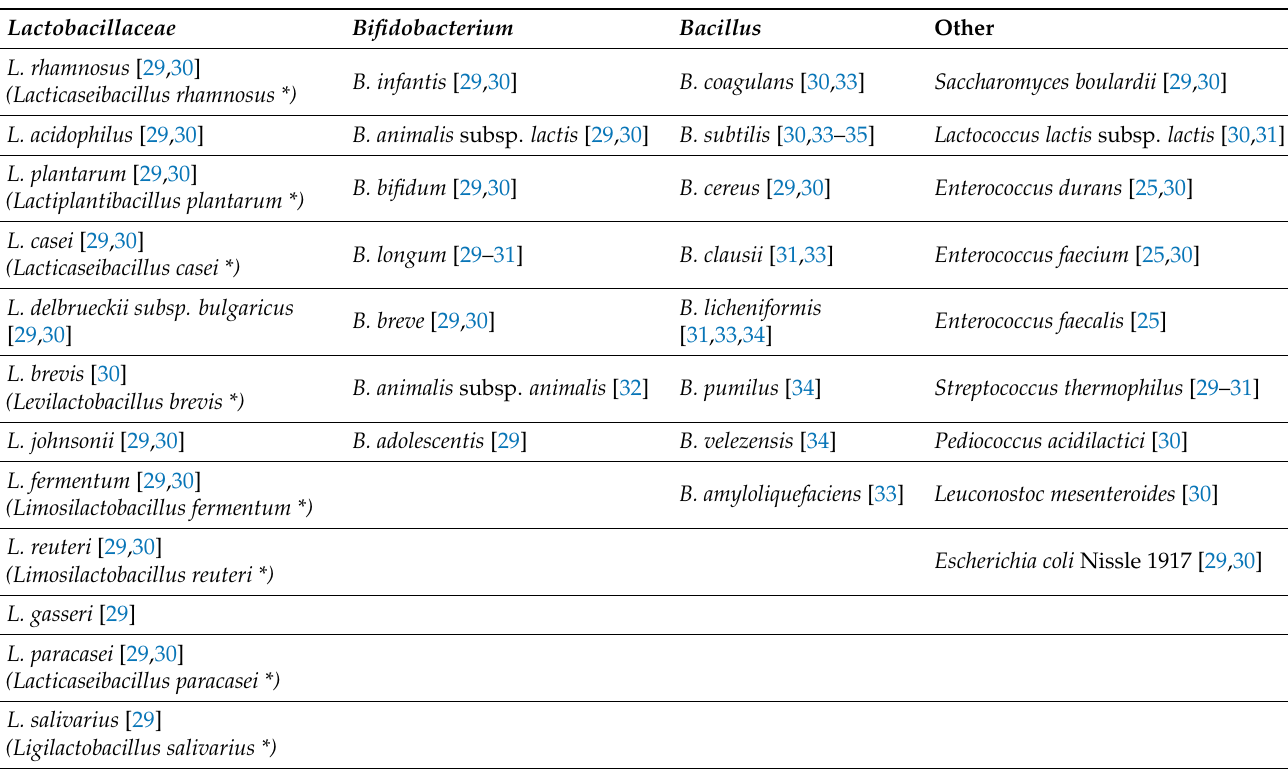
Table 1. Microbial species of which individual strains are classified as